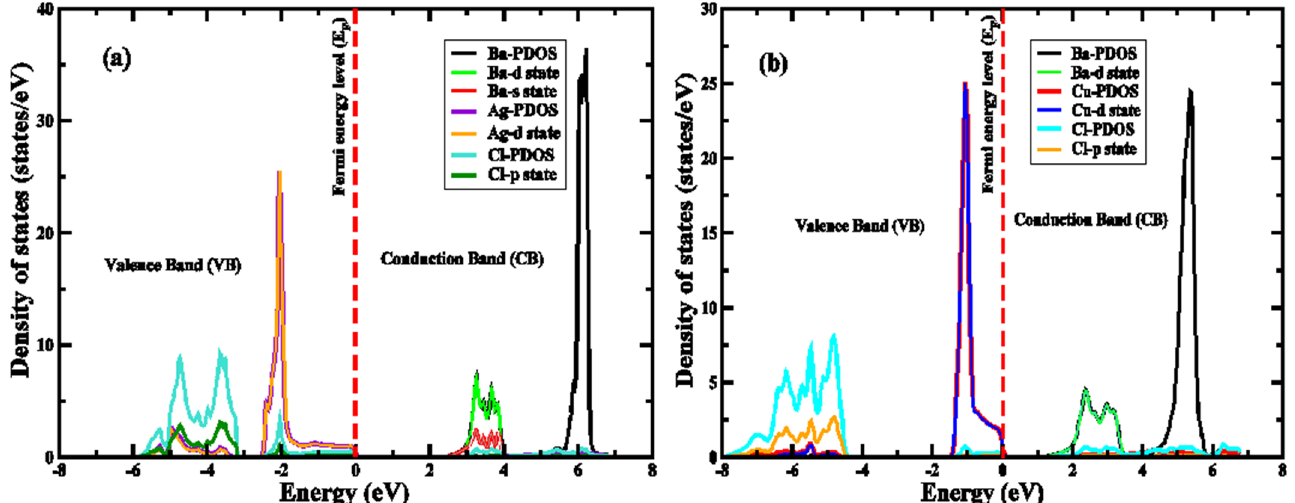
Figure 5. The TDOS and PDOS of ( a ) BaAgCl 3 and ( b ) BaCucCl 3 .